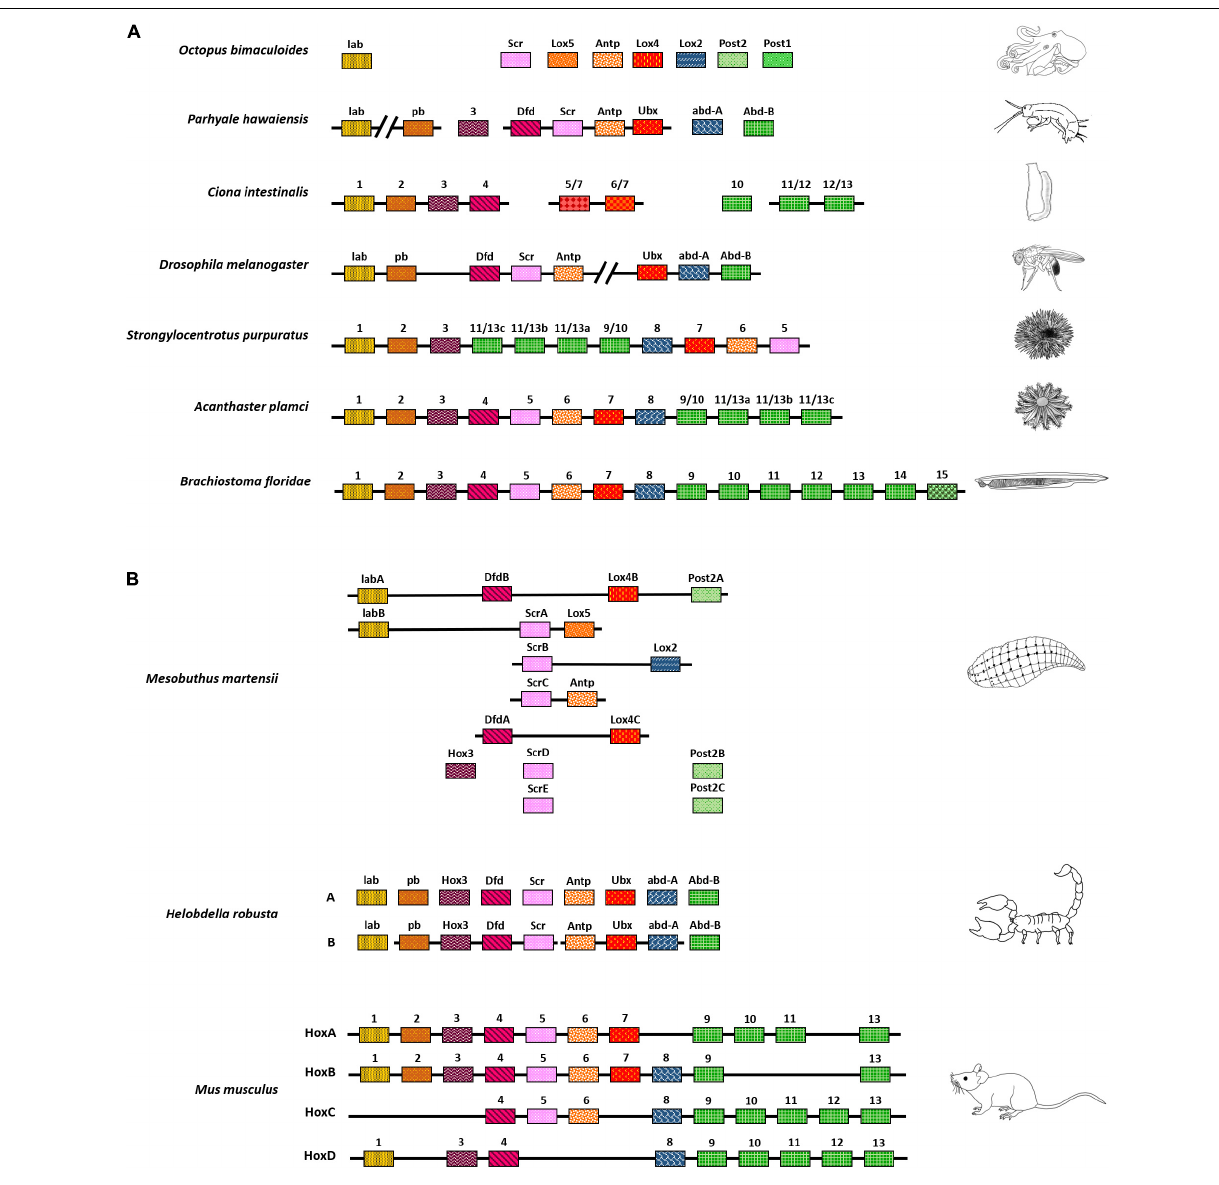
FIGURE 1 | Chromosomal arrangement of Hox genes. (A) Variety of Hox arrangement observed in different animals, from a completely scattered arrangement in octopus to a fully intact Hox cluster in Amphioxus. (B) Hox have also undergone duplication in several organisms. They have fragmented arrangements in animals such as the freshwater leech or are present in an intact cluster, as seen in vertebrates. The depiction here is independent of phylogeny and represents the order of clustering. Also, the organisms shown here do not represent their respective